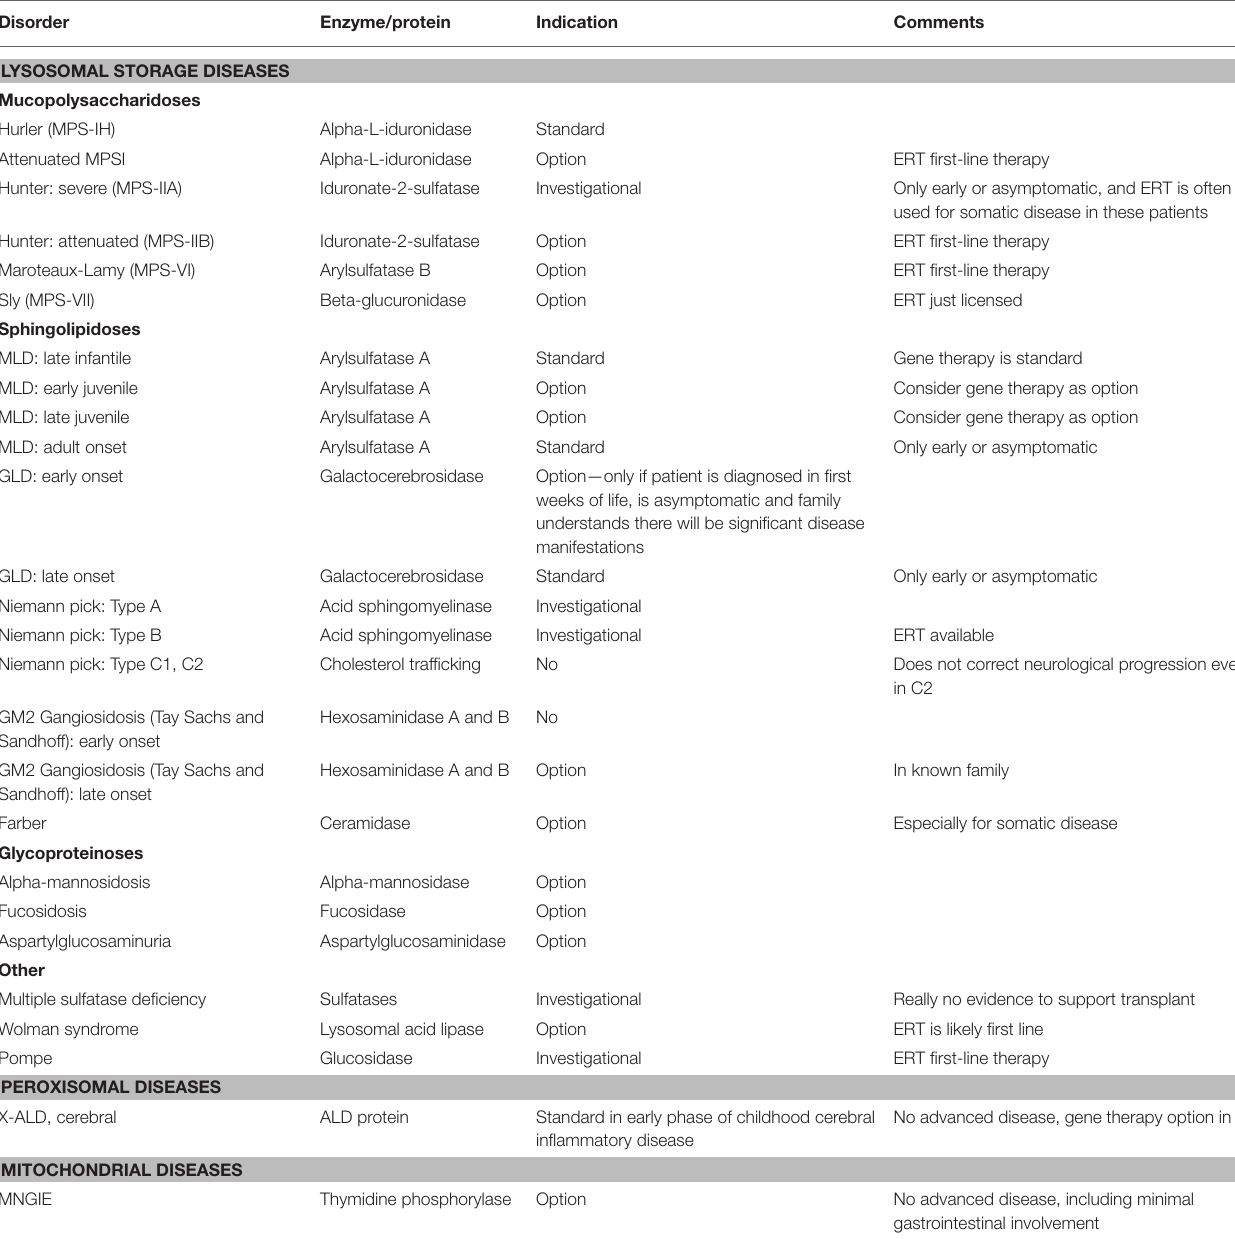
TABLE 1 | Inherited metabolic disorders where HSCT may be